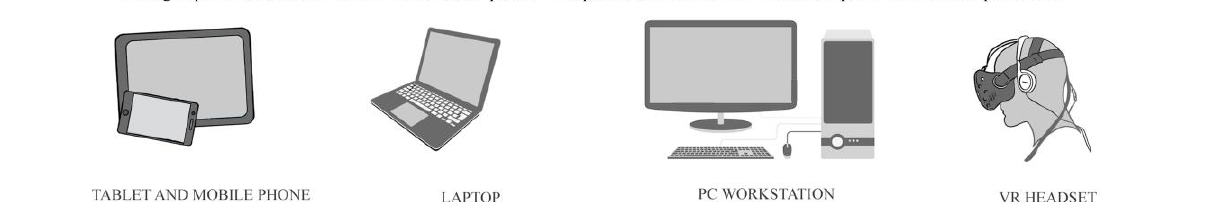
Figure.1 The research case studies in relation to the proposed digitisation process and multiple devices and XR